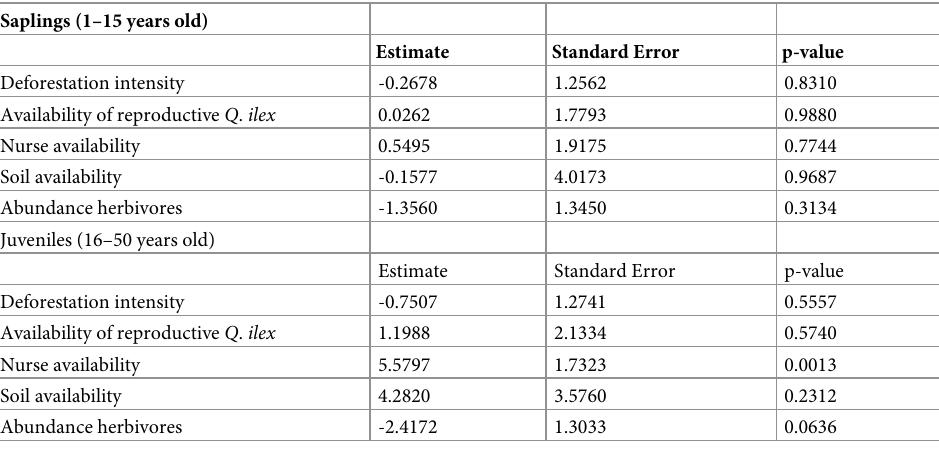
Table 3. Estimates of the interaction parameter ( β 11, S3 Appendix) between the indicator of the presence of nurse plants at the microsite level and the plot-level